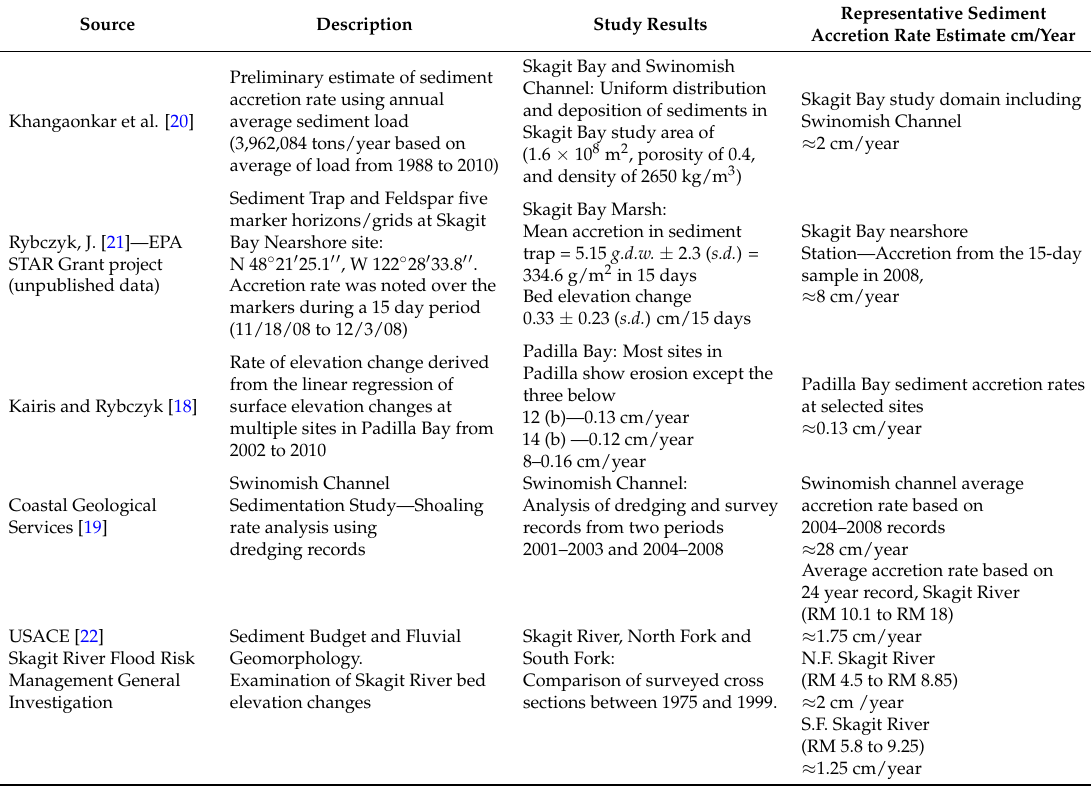
Table 2. Sediment accretion estimates in the Skagit River Estuary and Padilla Bay. ( g . d . w . stands for gram dry weight, and s . d . stands for standard